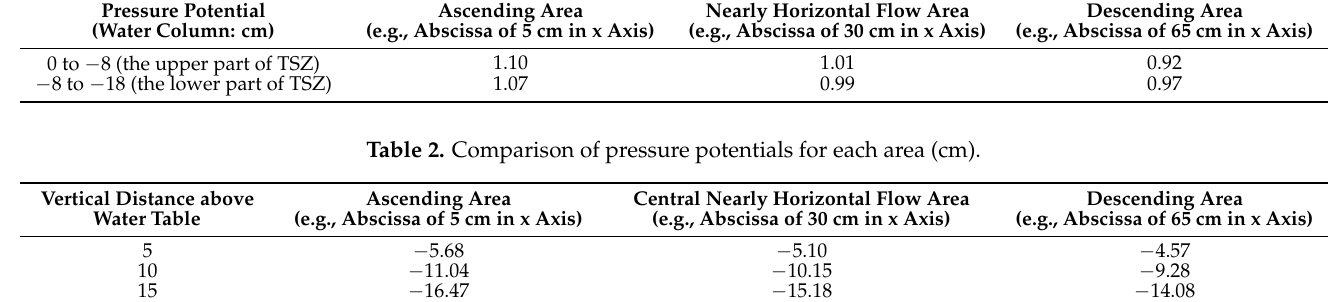
Table 1. Comparison of vertical pressure potential gradients for each area.